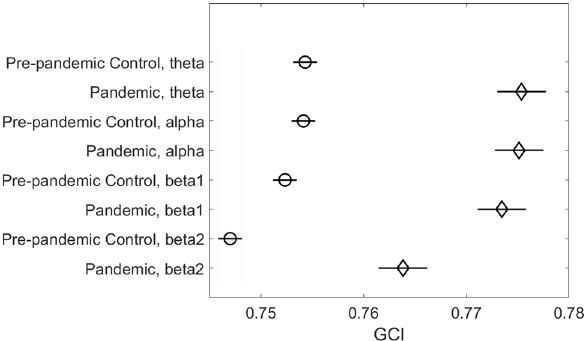
Figure 2. Group means of Global Connectivity Index in four EEG bands during Session-1 (before COVID-19 pandemic). Between-group differences in all bands were significant ( p < 0.01, ANOVA followed by Tukey post- hoc test). GCI was calculated as the averaged phase locking value (the measure of connectivity was based on the phase of the EEG signal) in the four canonical EEG bands: theta (4-7 Hz), alpha (8–12 Hz), beta-1 (14–20 Hz) and beta-2 (21–30 Hz). Created using MATLAB 2020a (The MathWorks, Inc, www. mathw orks. com).